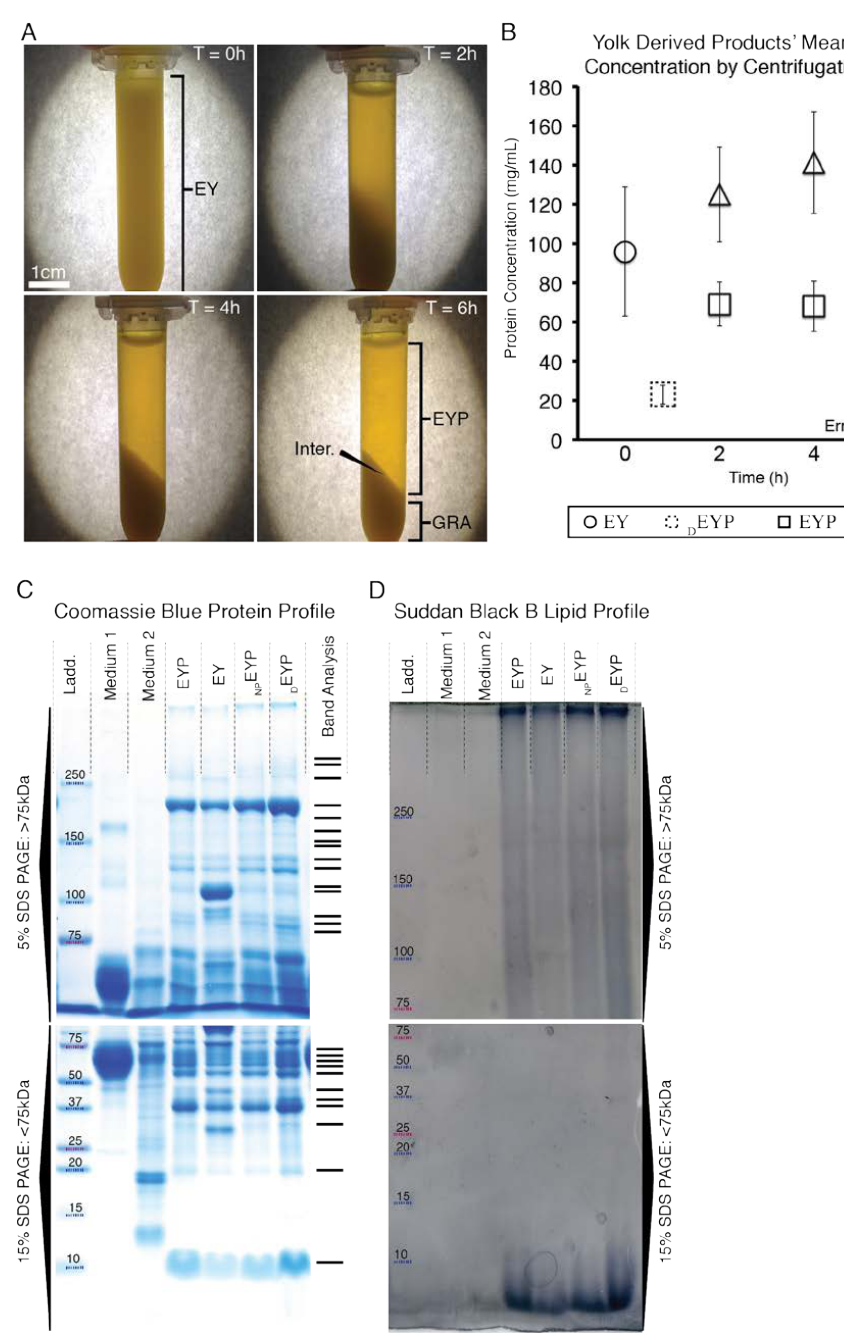
Figure 1. Images and Quantative Values of EYP During Centrifugation and Images of EYP, EY and Culture Media SDS-Pages Stained with Coomassie and Sudan Black B. ( A ) Images of 2 mL tubes after centrifugation and held in front of a lit piece of paper. After 6 h of spinning, the egg yolk (EY) becomes the egg yolk plasma (EYP) and granules (GRA) separated by an interface (Inter.) ( B ) Protein values of EY, EYP & GRA fractions as well as in Diluted EYP ( D EYP) over centrifugation times as quantified by Bicinconinic Acid assay. ( C , D ) The SDS-PAGESs 5% and 15% compare EYP to both used cell culture media: RPMI 1640 containing 10% FBS (Medium 1), EpiMax (Medium 2) and to EY, non-pasteurized EYP ( NP EYP) and D EYP. The protein standard ladder (Ladd.) is identical in all SDS-PAGEs. ( C ) A digital scan of SDS-PAGEs stained with Coomassie Blue (appearing as blue bands). Band Analysis indicates software detected peaks in only EYP profile. ( D ) A digital scan of SDS-PAGE stained with Suddan Black B comparing quantity of lipids (appearing as dark